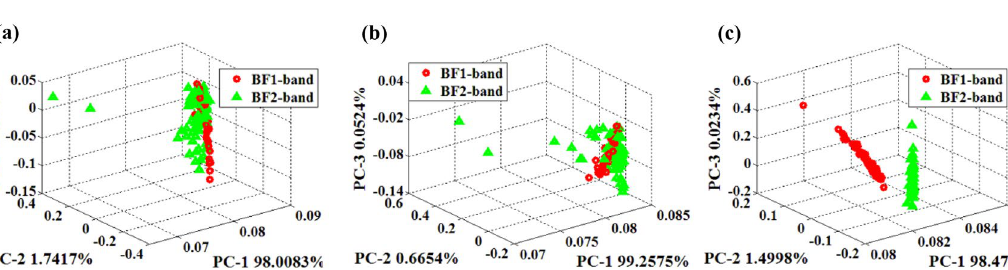
Figure 10. Feature extraction results of response image ( a ) GLCM feature, ( b ) LBP feature, ( c ) Gabor feature.